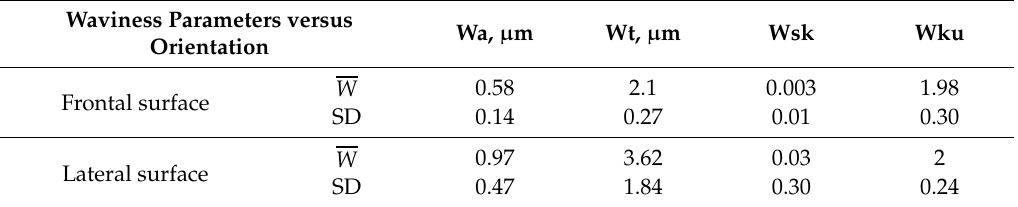
Table 5. Mean values of surface waviness parameters for 30 measurements for frontal and